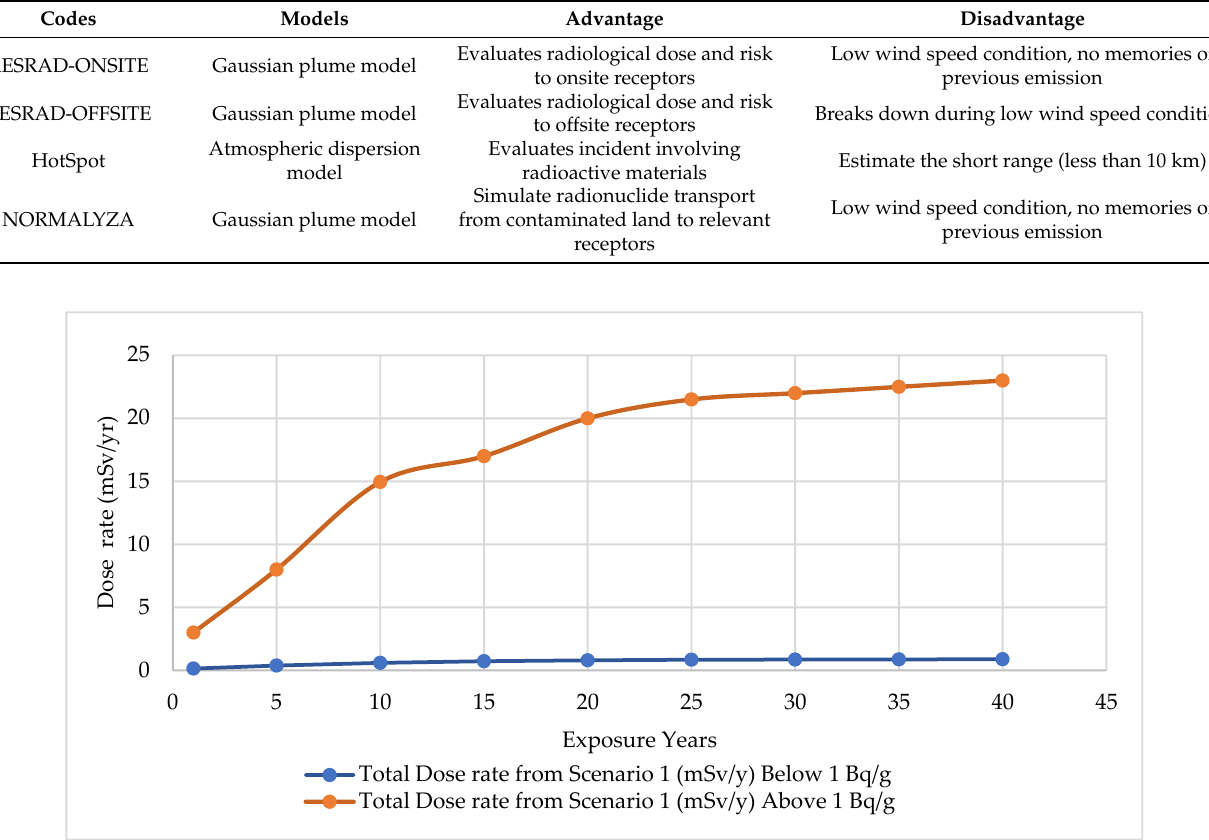
Figure 4. Results from RESRAD ONSITE